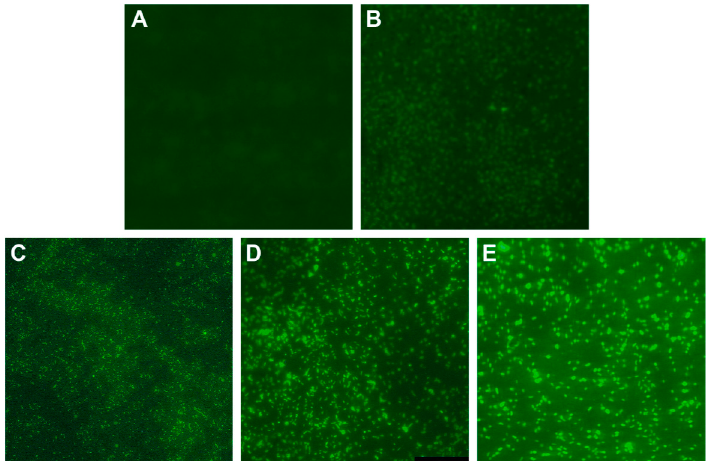
Figure 8. Changes of ROS production in multidrug-resistant Pseudomonas aeruginosa exposed to different concentrations of AgNPs under fluorescence microscopy with ×400 magnification. Notes: ( A ) the untreated P. aeruginosa without observable fluorescence. ( B – E ) Fluorescence observation of the bacteria exposed to 5.625, 11.25, 22.5 and 45 μ g/mL AgNPs, respectively, adapted with permission from [112], Dove Medical Press, 2019. Abbreviations: AgNP, silver nanoparticle; ROS, reactive oxygen specie.